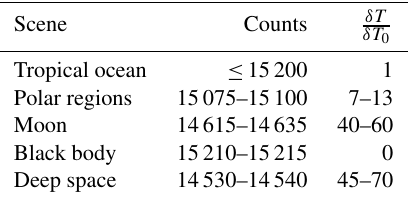
Table 3. The range of relative values of the cold space bias cor- rection δT in the measurement equation for different scenes. The counts are from channel 20 in different orbits with Moon intrusions from the year 2008. δT is the change in the calculated scene temper- ature due to the cold space temperature bias correction, where the subscript 0 indicates the value for observations over tropical